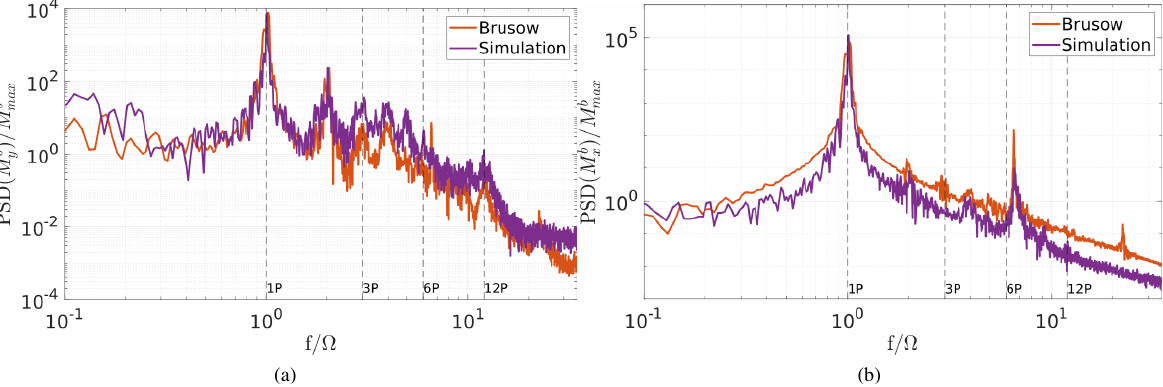
Figure 15. Spectrum of the blade root bending moment (a) out of plane M b y and (b) in plane M b x in comparison to the simulation results (stable). The data are normalised by the maximum value of the blade root bending moments.